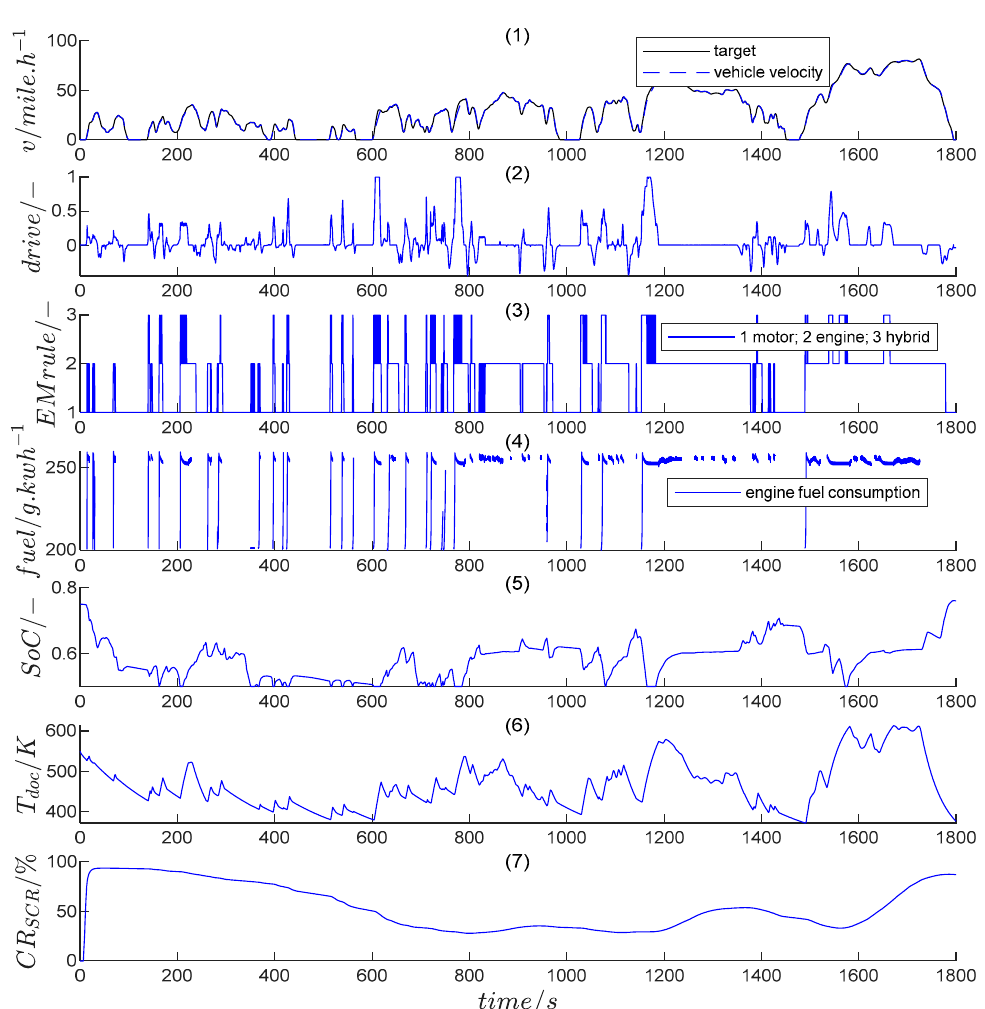
Figure 9. Working process of the diesel hybrid electric system under the RC method: ( 1 ) the speed target of the WLTC cycle and the tracking states of the controller, ( 2 ) the normalized curve of the braking force and driving force, ( 3 ) the switching process of energy mode rule (EM rule), 1 represents the motor mode, 2 represents the engine mode and 3 represents the hybrid mode, ( 4 ) the instantaneous fuel consumption of the engine, ( 5 ) SoC , ( 6 ) T doc , ( 7 ) the NO x conversion efficiency in the SCR system.